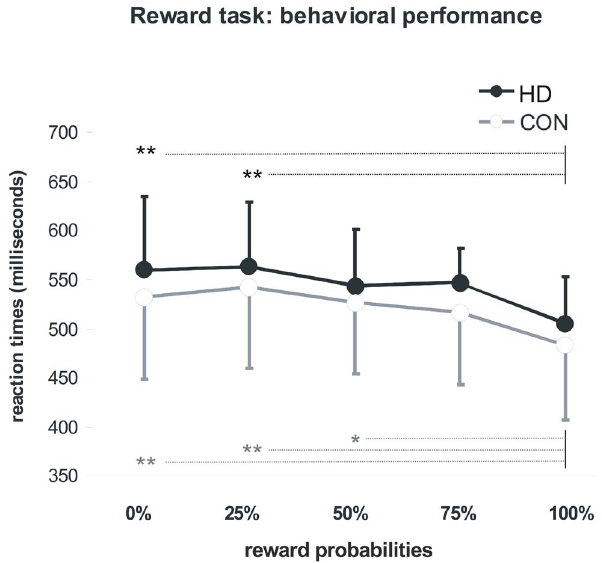
Fig. 1. Reaction times: Mean reaction times and their standard deviation in the fMRI reward task. **: p # 0.001 in post hoc testing. *: p , 0.005 in post hoc testing. HD: Huntington disease mutation carriers, CON: control subjects.